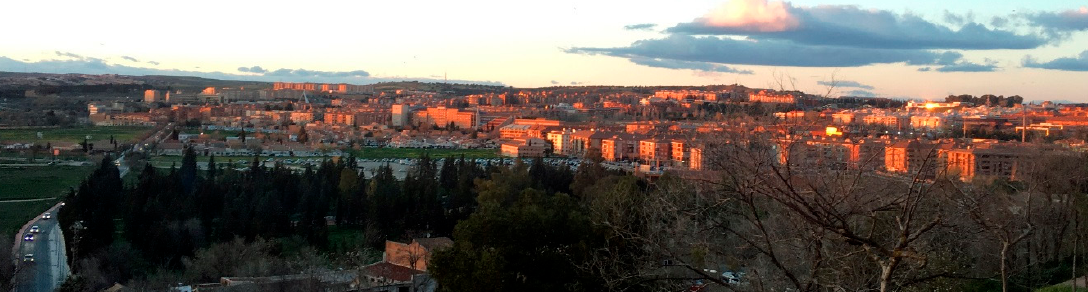
Figure 6. Panoramic view of the Ensanche of Toledo.